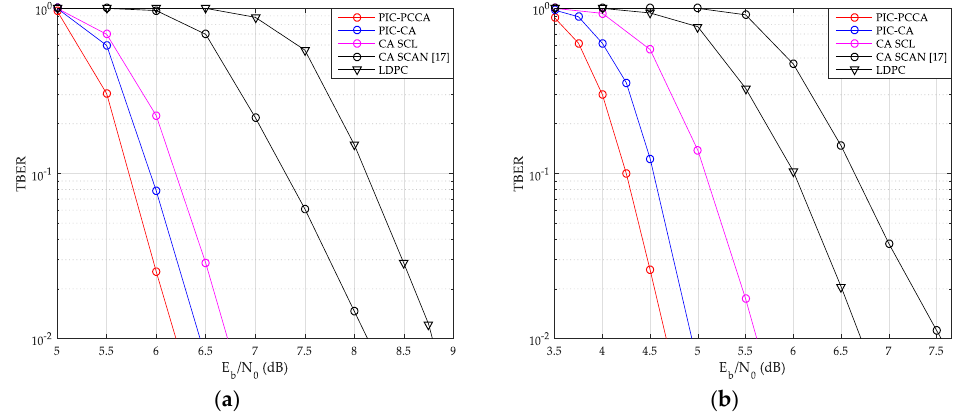
Figure 16. TBER of SCMA over Rayleigh channel. ( a ) K = 100, R = 1/2; ( b ) K = 64, R = 1/3. Table 2. Gain of PIC PCCA-PC-SCMA vs. other SCMA systems (dB). Parameters Polar Parameters